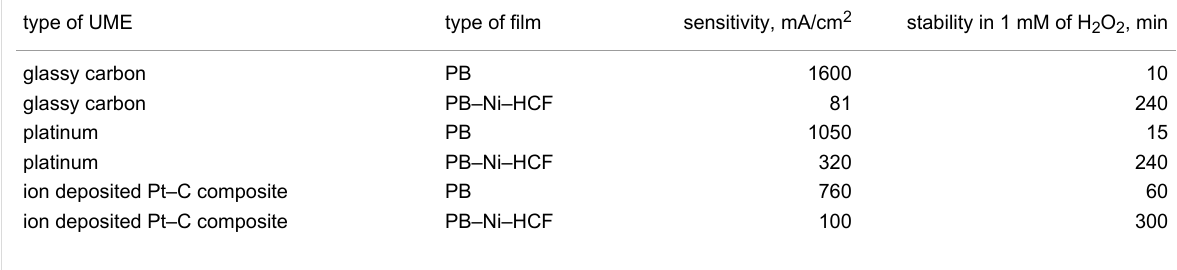
Table 1: Sensitivity and operational stability of the ultramicrosensors (pH 6, batch regime).